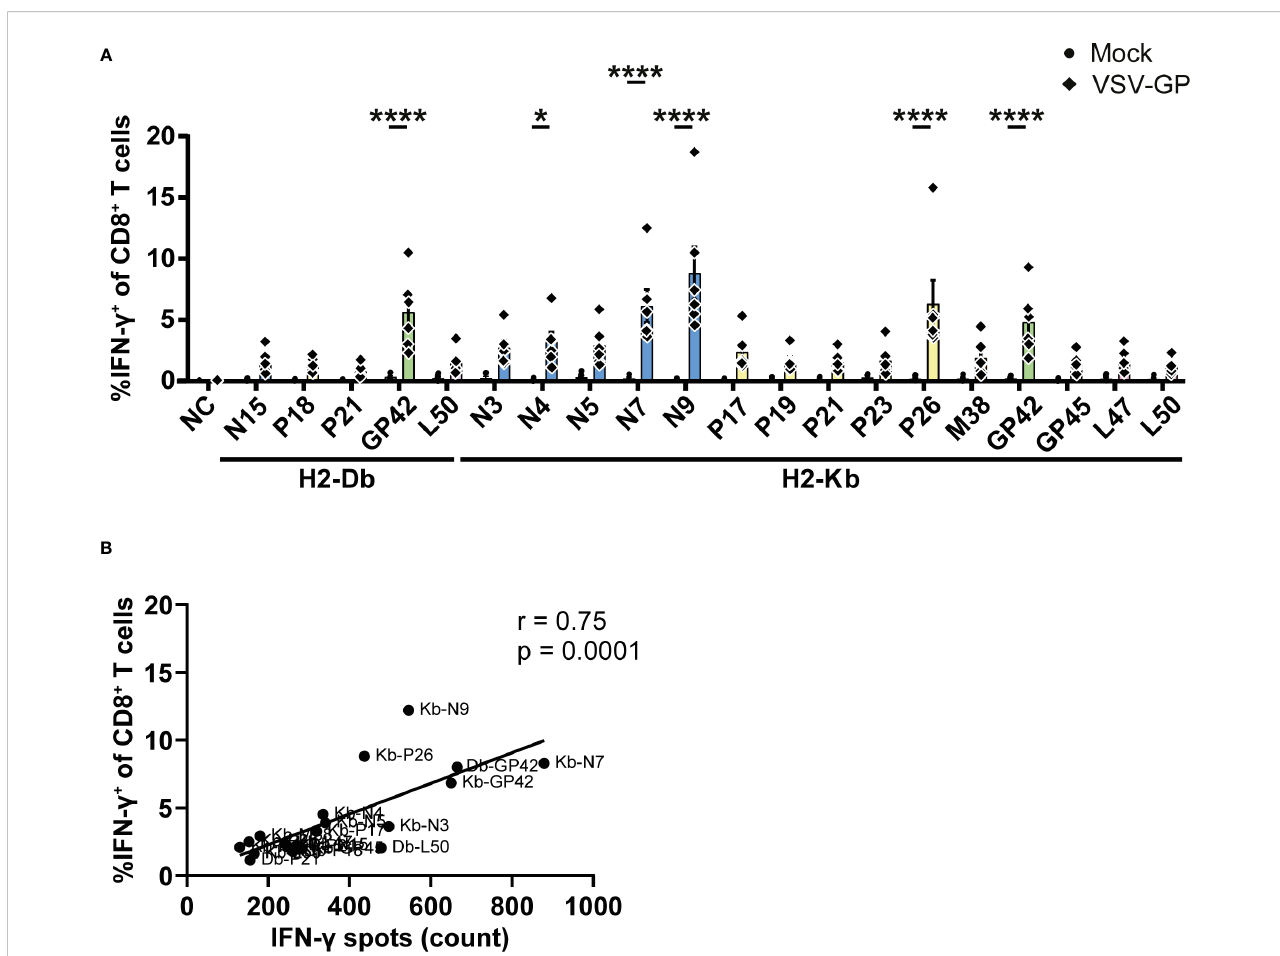
FIGURE 5 Intracellular cytokine staining upon stimulation with the identi fi ed VSV-GP T cell epitopes. (A) Frequencies of IFN- g + CD8 + T cells of splenocytes from mock or VSV-GP treated mice upon stimulation with individual peptides (10 µg/ml). The negative control (NC) is unstimulated cells (n=6 for mock, n=6 for VSV-GP, from three independently performed experiments). Signi fi cant differences between mock and VSV-GP treatment are indicated with asterisks (tested using two-way ANOVA with Sidak ’ s multiple comparison). *p < 0.05; ****p ≤ 0.0001. (B) Correlation of matching ICS and IFN- g ELISpots (using Pearson correlation coef fi cient). Bar color represents from which viral protein the epitope is